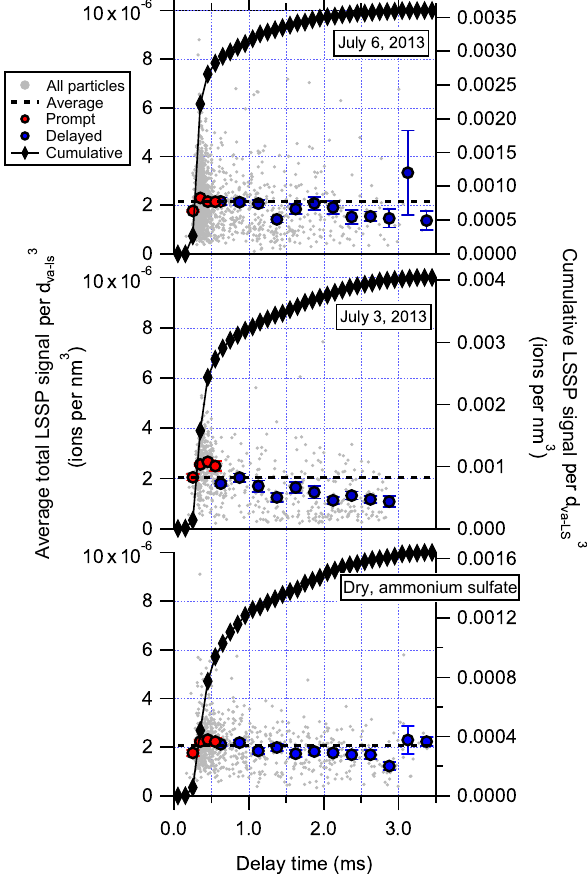
Figure 6. Average total LSSP signals normalized to (d va-LS ) 3 as a function of delay time for the flight with the highest average am- bient CE (6 July 2013, top), the flight with the lowest average ambi- ent CE (3 July 2013, middle), and dry ammonium sulfate particles (obtained 13 March 2015,